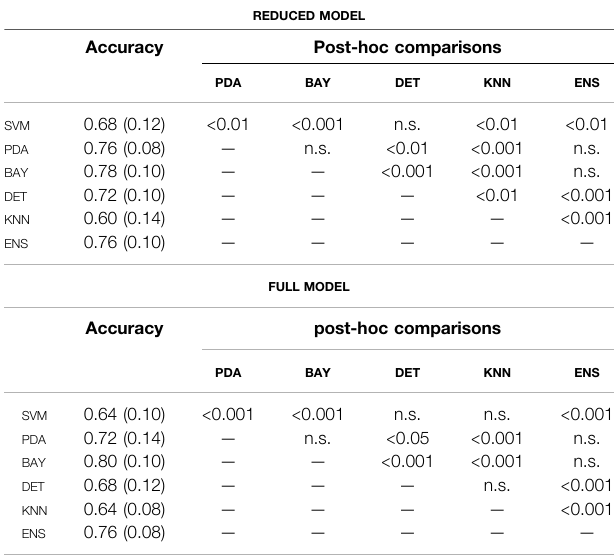
TABLE 3 | Accuracy (median and interquartile range), and statistical signi fi cance ( p -value) of the post-hoc comparisons, among the classi fi cation algorithms (pre-selection phase, fi g.5) for reduced and full